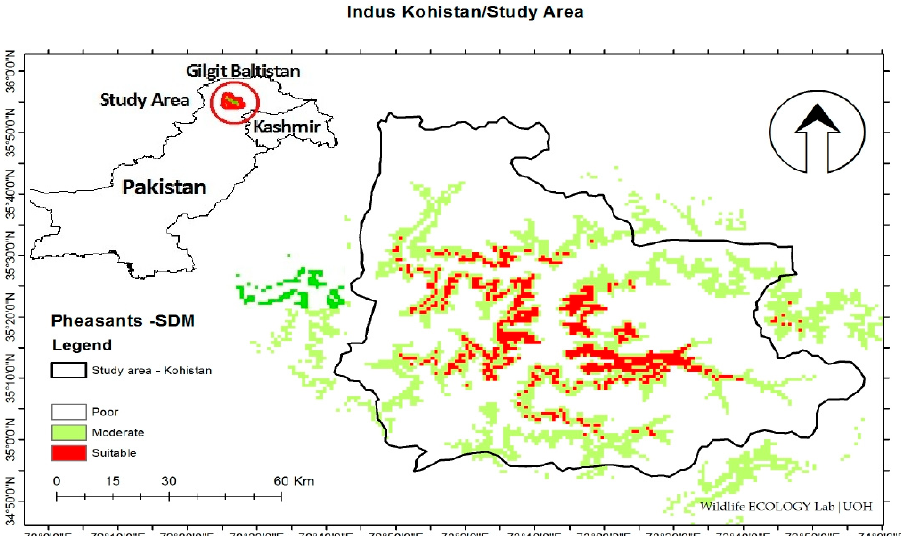
in the study Figure 3. Species distribution modeling (MaxEnt) predicted suitable habitats for the pheasant spe- cies in the study area.